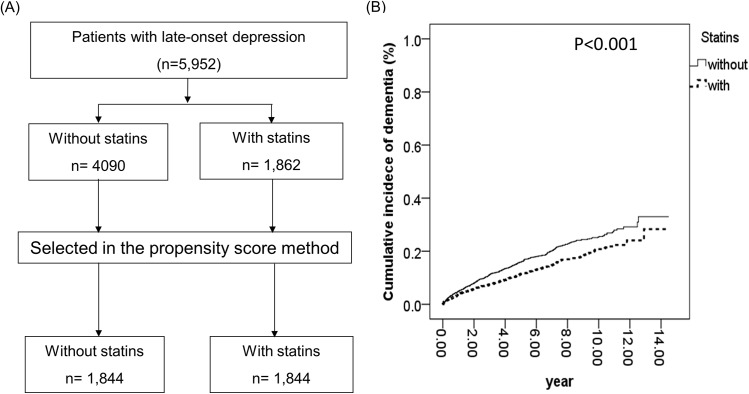
The effect of statins in reducing the risk of subsequent dementia in patients with late-onset depression.(A) Flowchart showing the matching process for statins users and non-users in the population studied. Finally, 1,844 pairs of matched patients were selected for analysis using the propensity score method, which minimizes interference by confounding factors. (B) Statins reduced the occurrence of subsequent dementia in patients with LOD (p < 0.001).